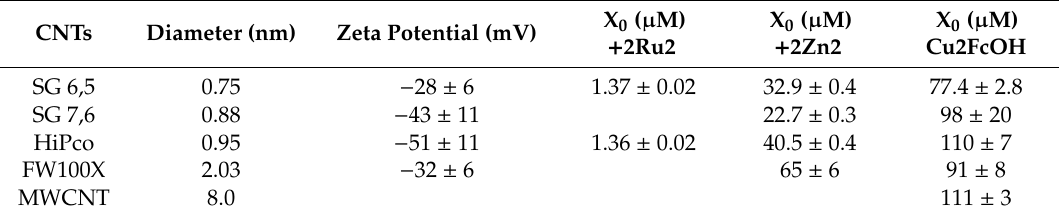
Table 2. Dispersion stability of various CNTs against the addition of various Table 2 . Dispersion stability of various CNTs against the addition of various coagulants.